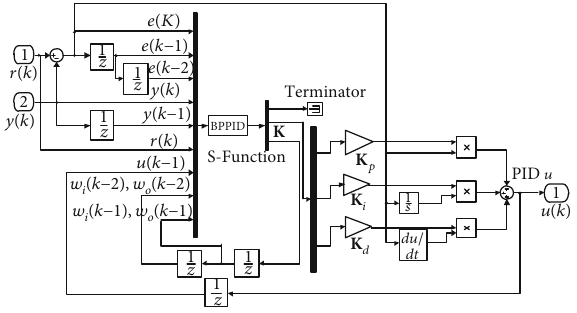
Figure 3: The diagram of the BP neural network PID